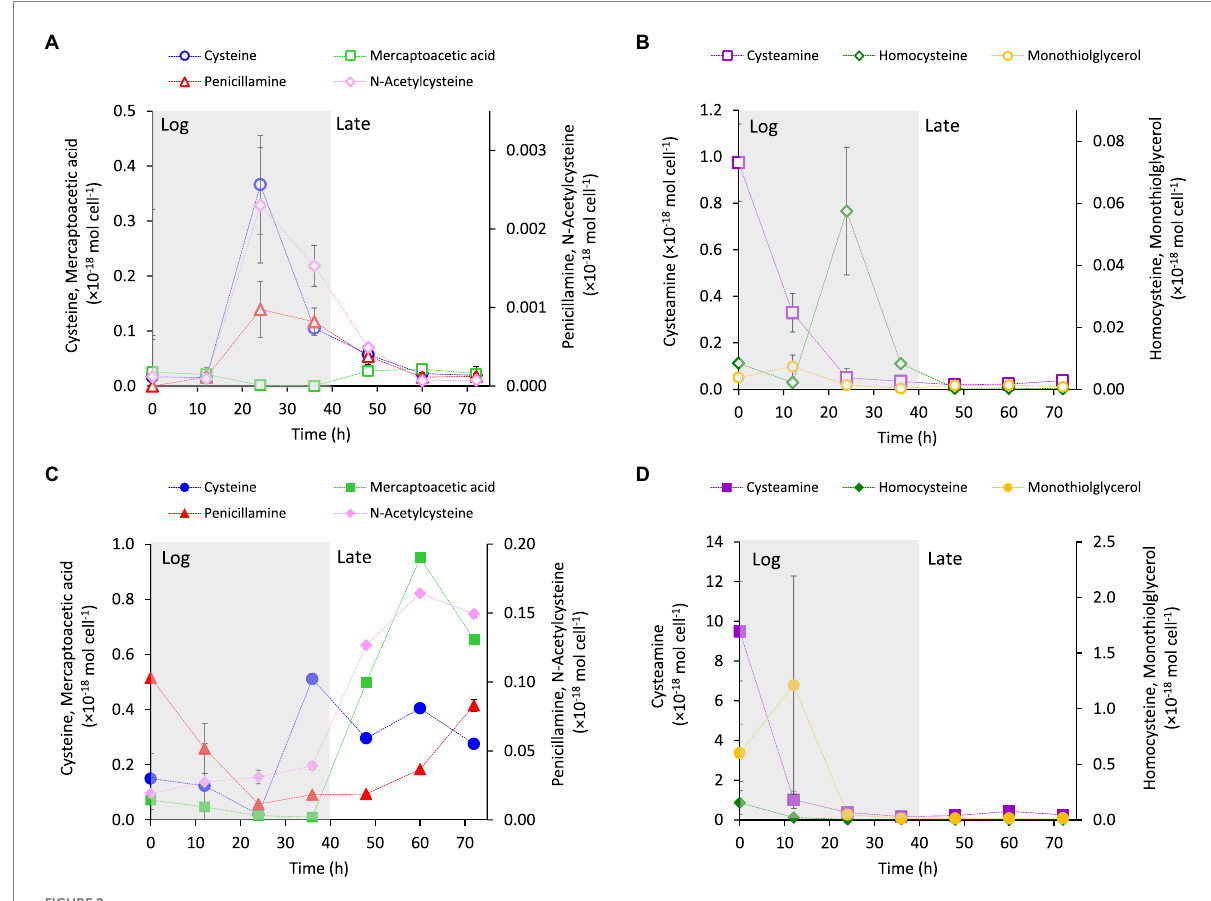
FIGURE 2 Average concentrations normalized to cell density (mol cell − 1 ) of cysteine-related LMM thiols (A,B) intracellular and (C,D) in the extracellular growth medium over time at addition of 3.7 μ M Fe(II) to the growth medium. The main growth phases: exponential growth (Log) and late exponential-stationary growth (Late) are indicated by shading in the figure (see Supplementary Figure S1A for growth curves). Error bars represent standard error, n = 4 and are smaller than visible in most